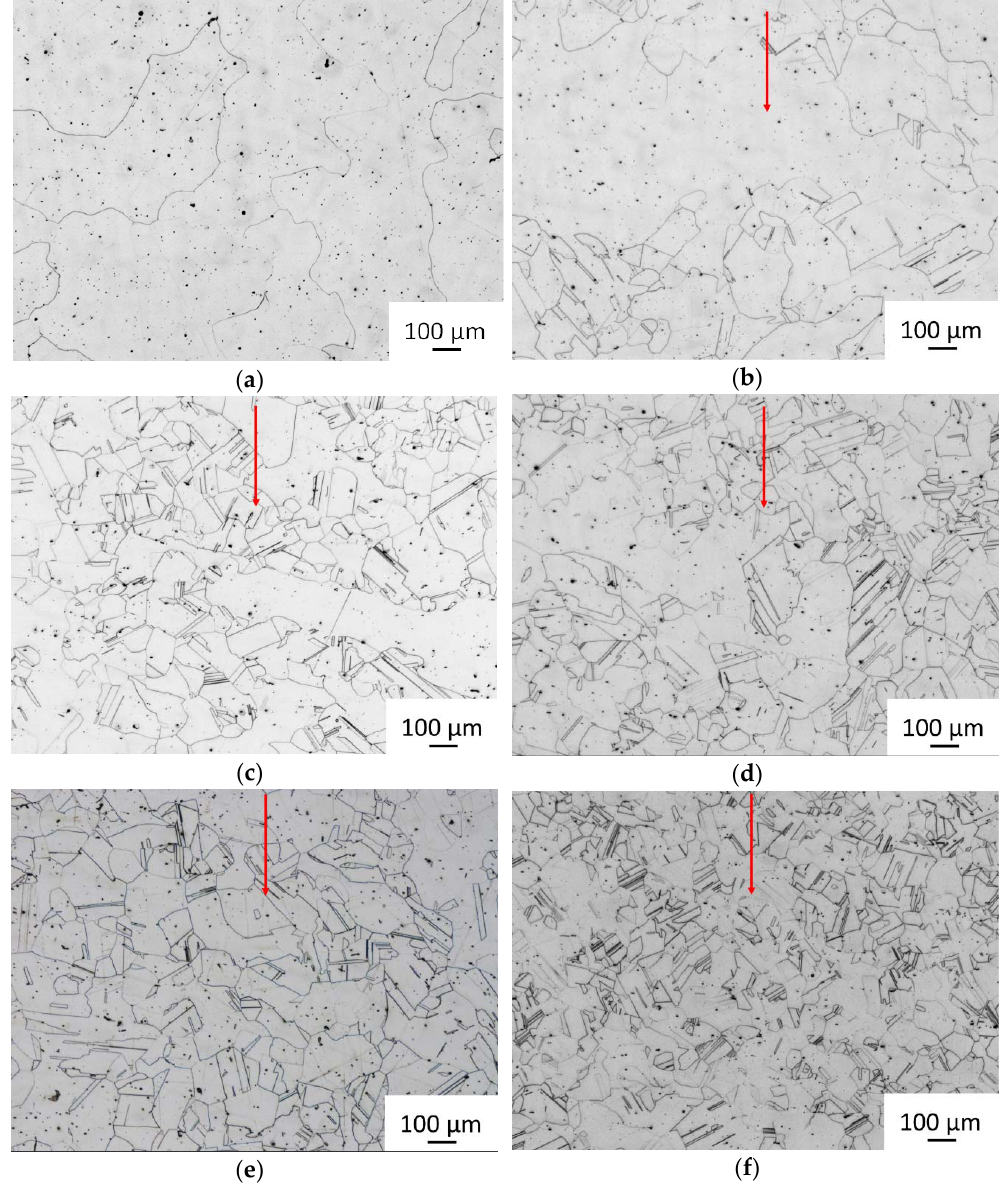
Figure 11. Recrystallization of the HN80MTY alloy: ( a ) initial as-annealed condition; ( b ) 5%; ( c ) 10%; ( d ) 15%; ( e ) 20%; ( f ) 25%. Red arrows indicate the direction of the deformation. Different amounts of deformation followed by recrystallization produce very different recrystallized grain size distributions in both materials. After lower ‐ magnitude (5%) deformation, coarse grains form probably because the introduced strain is no higher than the critical level. Such a level is sufficient for recrystallization to start but the resultant grain size may be extremely coarse [14]. The deformation at 25% led to strain levels which enabled fine recrystallized grains to form. after subsequent recrystallization annealing. After annealing, no significant differences were found between the deformation states. Nevertheless, it is remarkable that both materials exhibit deviations at 5% deformation: A hardness decrease in MoNiCr and a hardness increase in HN80MTY.